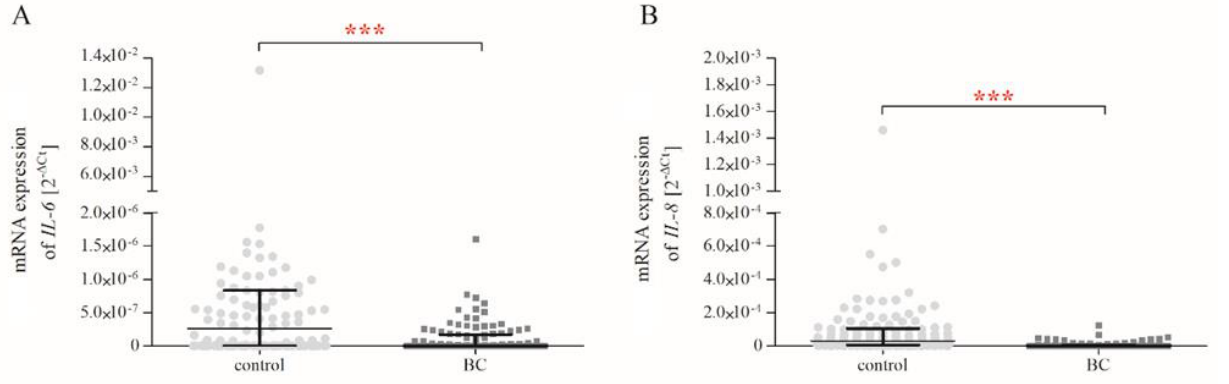
Figure 2. Basal mRNA expression of IL-6 ( A ) and IL-8 ( B ) genes in PBMCs of controls (n control = 114) and patients with BC (n patients with BC = 116). Basal gene expression levels were calculated using the 2 − ∆ Ct method (C t gene − C t 18S ). The data are plotted as individual values and the median with interquartile range is indicated by the horizontal bars; ***— p < 0.001.